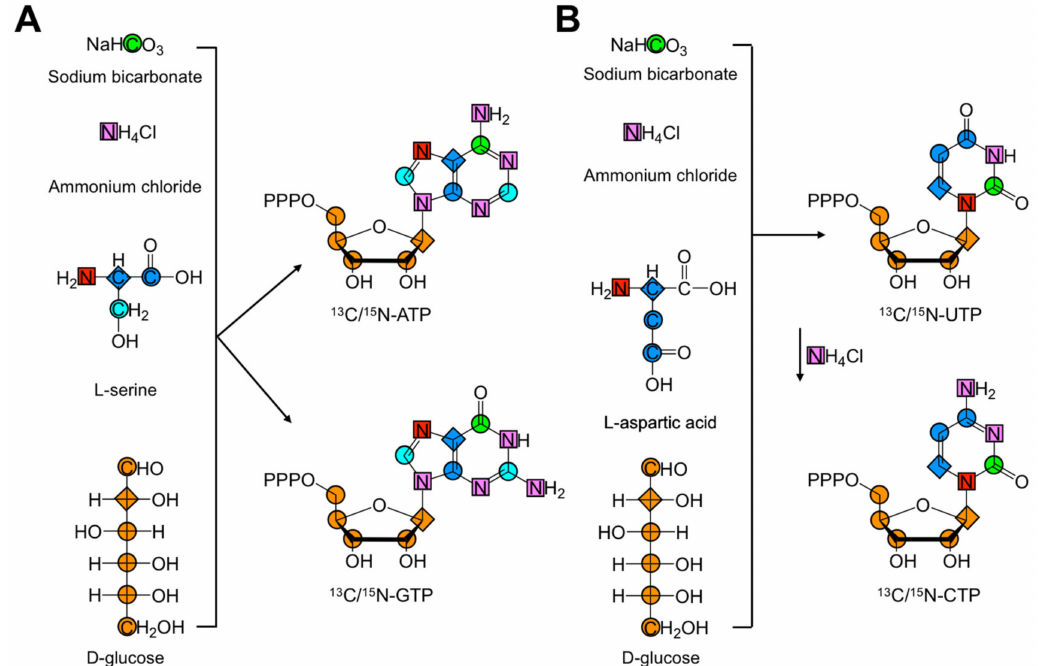
Figure 3. De novo biosynthesis of rNTPs adapted from Williamson and co-workers [27,28]. The four isotope-labeled precursors needed for the de novo biosynthesis of uniformly 13 C/ 15 N-labeled ( A ) purine and ( B ) pyrimidine rNTPs are shown, and the heteroatoms are color coded to match their corresponding labeling positions. As shown in ( B ), UTP is converted to CTP in one additional step. For consecutive carbon atoms that are incorporated concomitantly, the first position is diamond shaped to indicate the direction of incorporation. All colored shapes represent either a 13 C or a 15 N atom. The isotope label of the C1 of glucose can complicate the label of C6 in the purine nucleobase. Care is usually taken to prevent dilution. Additional details can be found in the original works